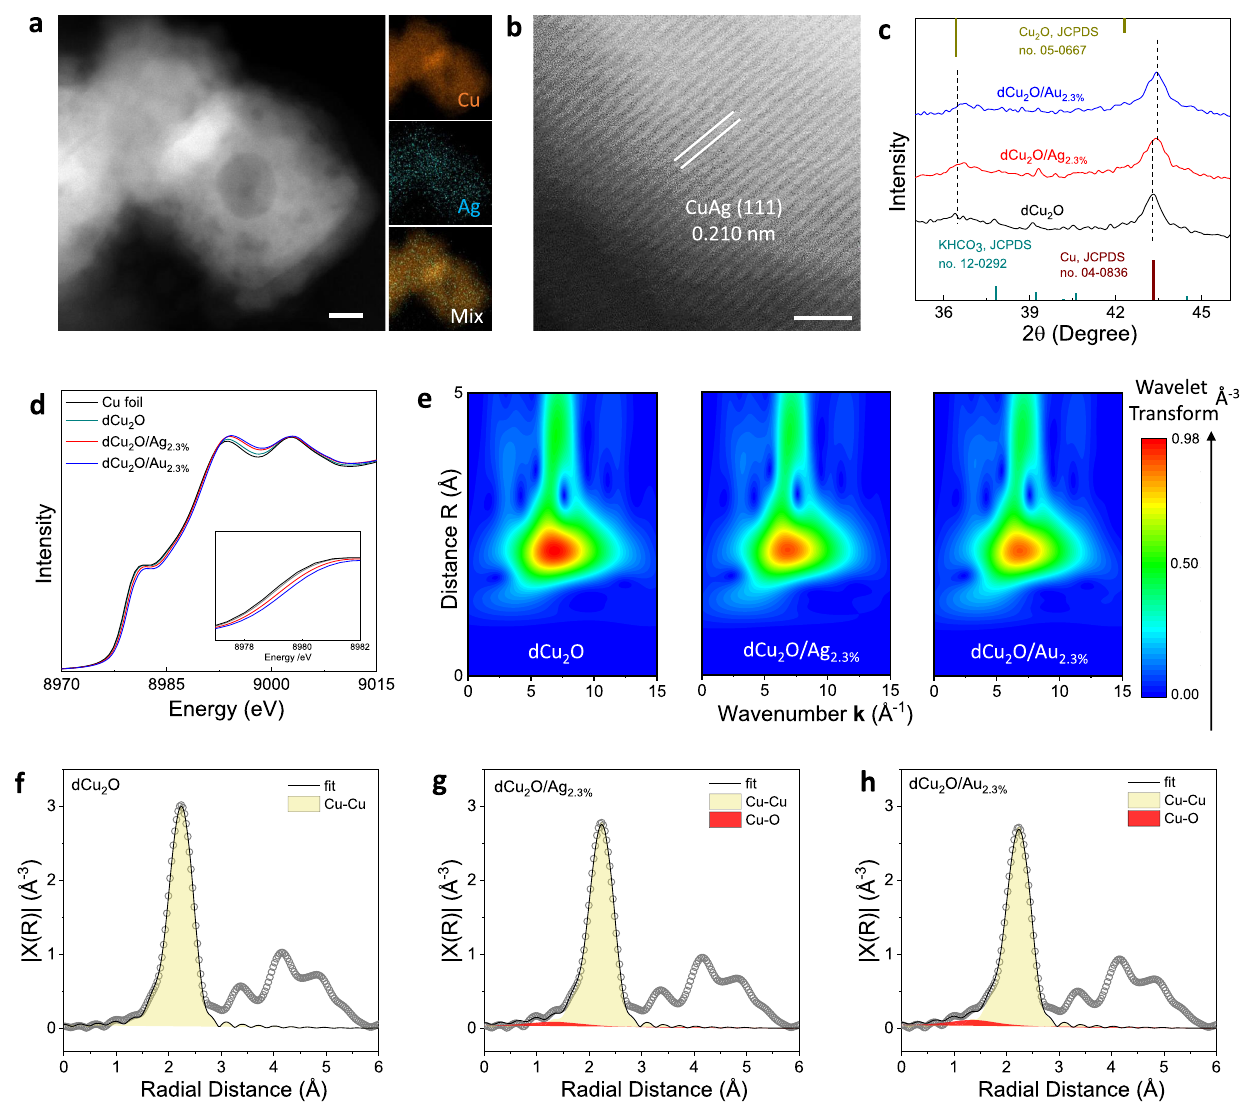
Fig. 2 Phase and coordination environment for dCu 2 O/Ag catalysts. a HAADF – STEM image with EDS elemental mappings and b high resolution STEM image of dCu 2 O/Ag 2.3%. c Enlarged XRD patterns for dCu 2 O, dCu 2 O/Ag 2.3% and dCu 2 O/Au 2.3% . d In situ XANES spectra and e Wavelet transform images of EXAFS data with optimized Morlet parameter (i.e., κ = 5, σ = 1) at Cu K-edge for commercial Cu-foil, dCu 2 O, dCu 2 O/Ag 2.3% and dCu 2 O/Au 2.3% . Fourier transform curves of in situ EXAFS data and corresponding fi tted results ( fi rst coordination shell) for f dCu 2 O, g dCu 2 O/Ag 2.3% and h dCu 2 O/Au 2.3% . Scale bars, 10 nm in ( a ) and 1 nm in ( b